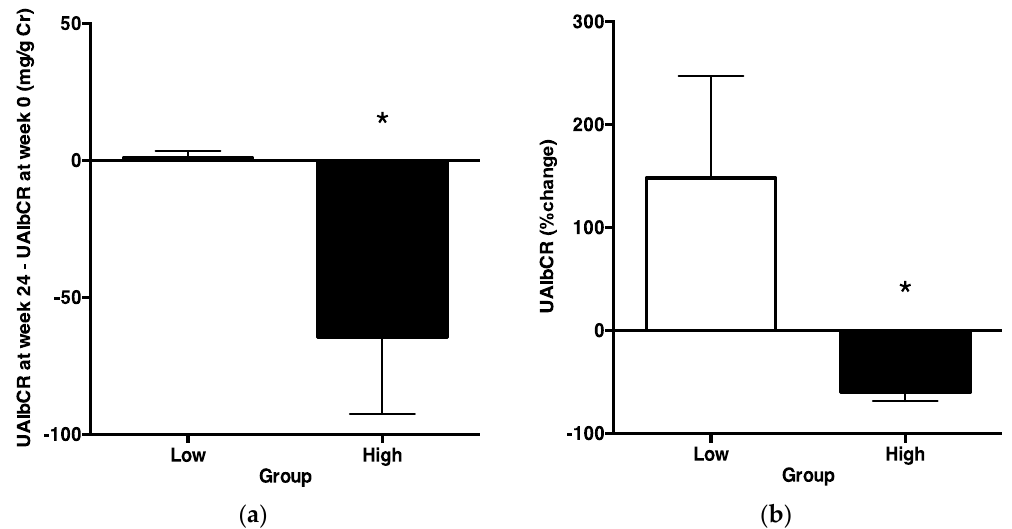
Figure 6. Δ Urinary albumin/creatinine ratio and % change in the urinary albumin/creatinine ratio portioned by the cutoff value of the urinary angiotensinogen/creatinine ratio before treatments. They were compared between thetwo2 groups using the unpaired t -test. p < 0.05 was considered as statistically significant. ( a ) The Δ Urinary albumin/creatinine ratio was significantly lower in Group H than in Group L; ( b ) in addition, the % change in the urinary albumin/creatinine ratio was significantly lower in Group H than in Group L (* p < 0.05). Table 4. Clinical characteristics of the low urinary angiotensinogen (AGT) group and the high urinary AGT group at the baseline.